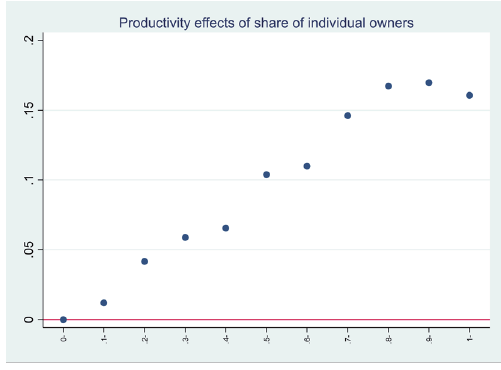
Fig. 4 – The effects of the share of individuals in equity (categorised) on TFP. Source: own